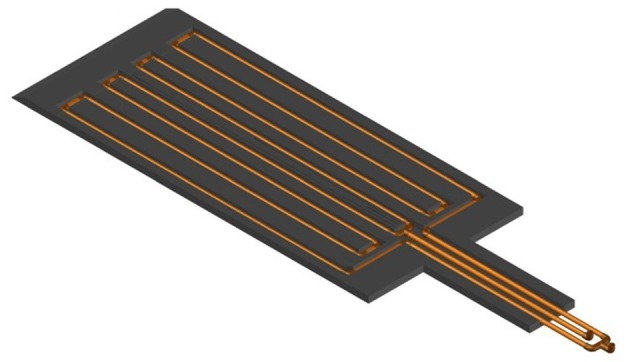
Cooling pad base and cooling water pipes [Extracted from Cabezón et al. (30).